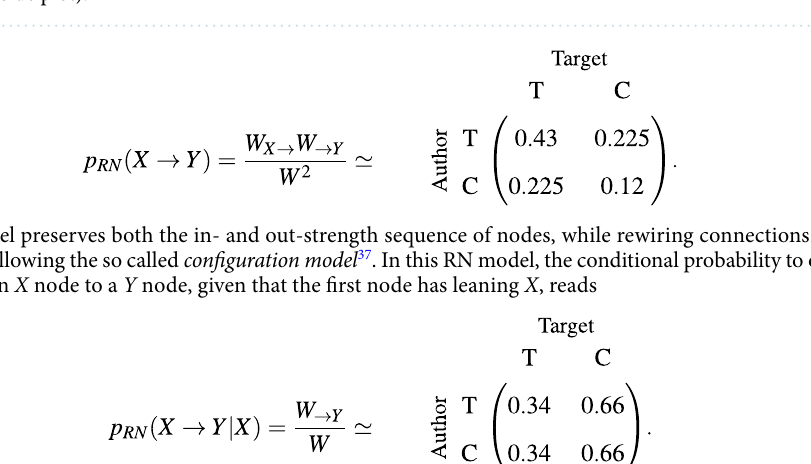
Figure 2. Difference between empirical and random joint probabilities (left) and between empirical and random conditional probabilities (right) of interaction in the Politics network, with respect to Trump and Clinton supporters. We observe heterophily and asymmetry: off-diagonals are larger than zero and show distinct values (right-side